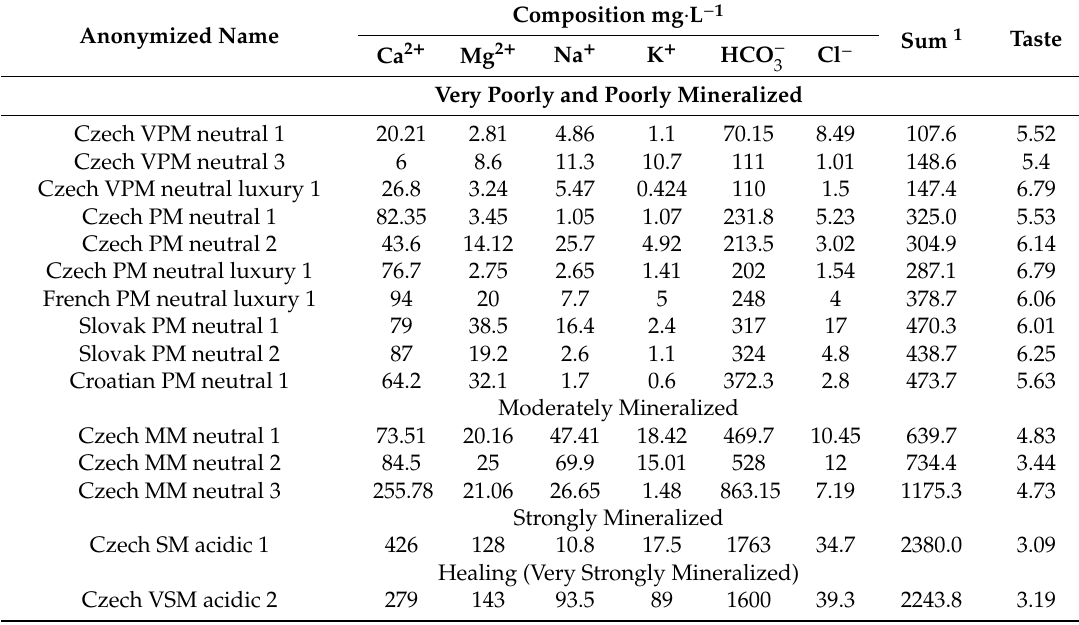
Table 3. Measured parameters of mineral waters in Central